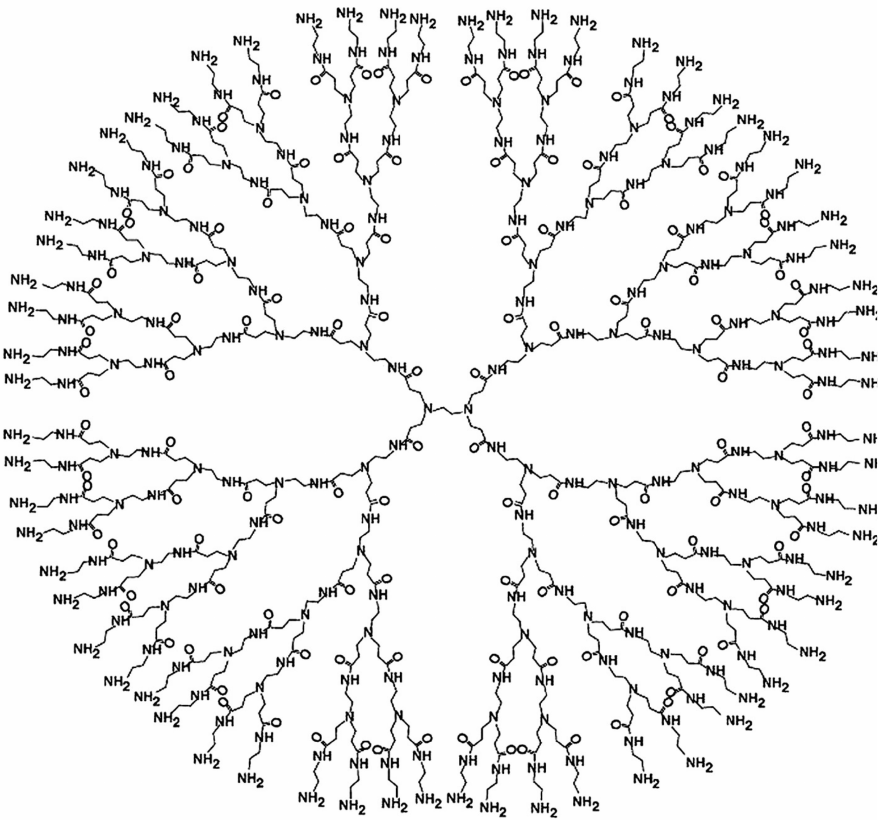
Figure 1. Chemical structure of poly(amidoamine) (PAMAM) G4. With the permission of